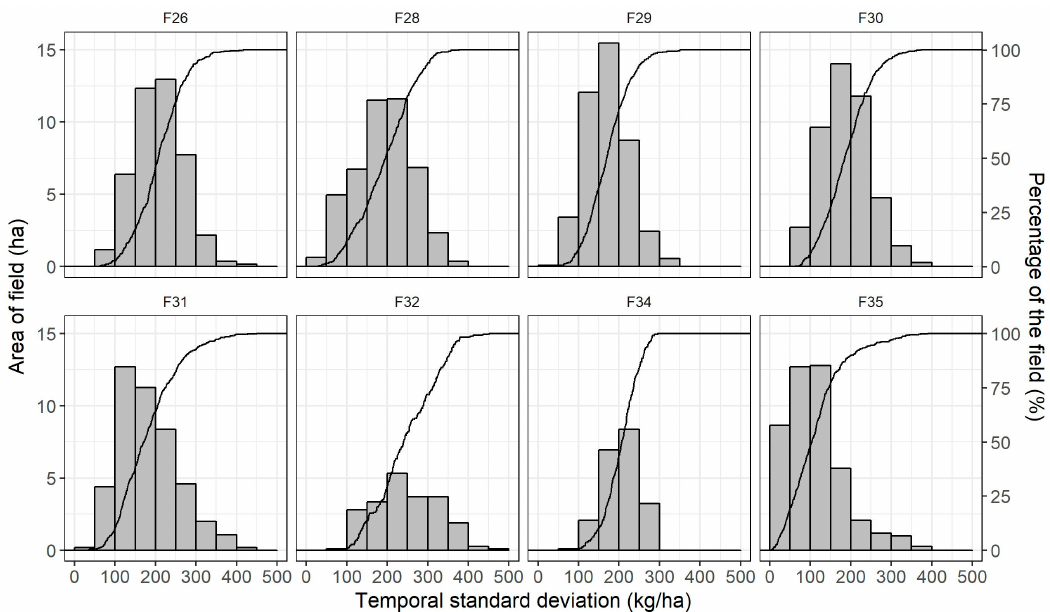
Figure 6. Frequency distribution by area (ha) of temporal standard deviation of cotton yield for eight fields in the Southern High Plains 2000–2003.